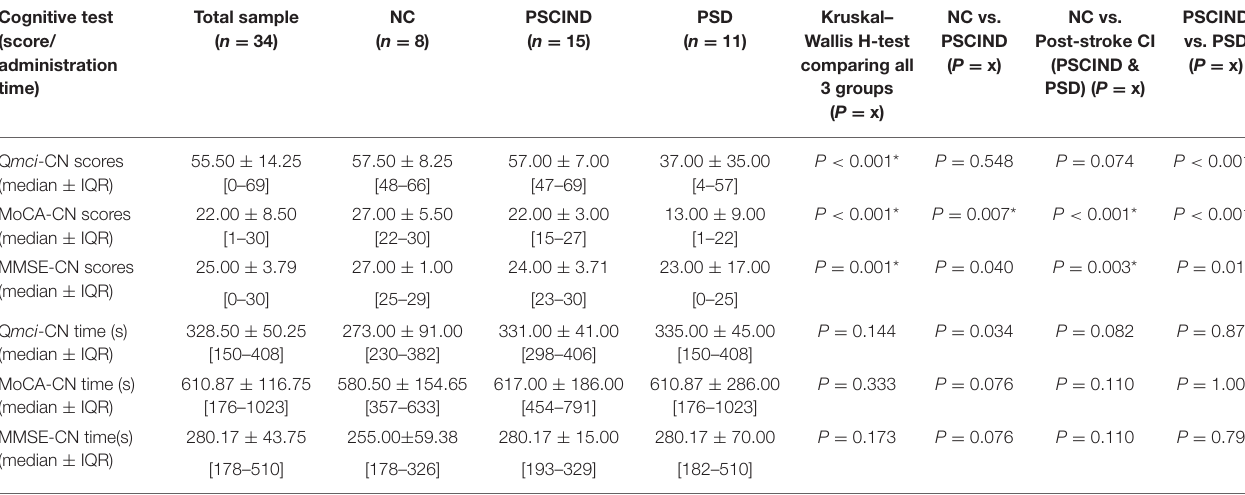
TABLE 2 | Test scores and administration times for the Chinese versions of the quick mild cognitive impairment screen (Q mci -CN), montreal cognitive assessment (MoCA-CN) and mini mental state examination (MMSE-CN) by diagnostic group. Cognitive test